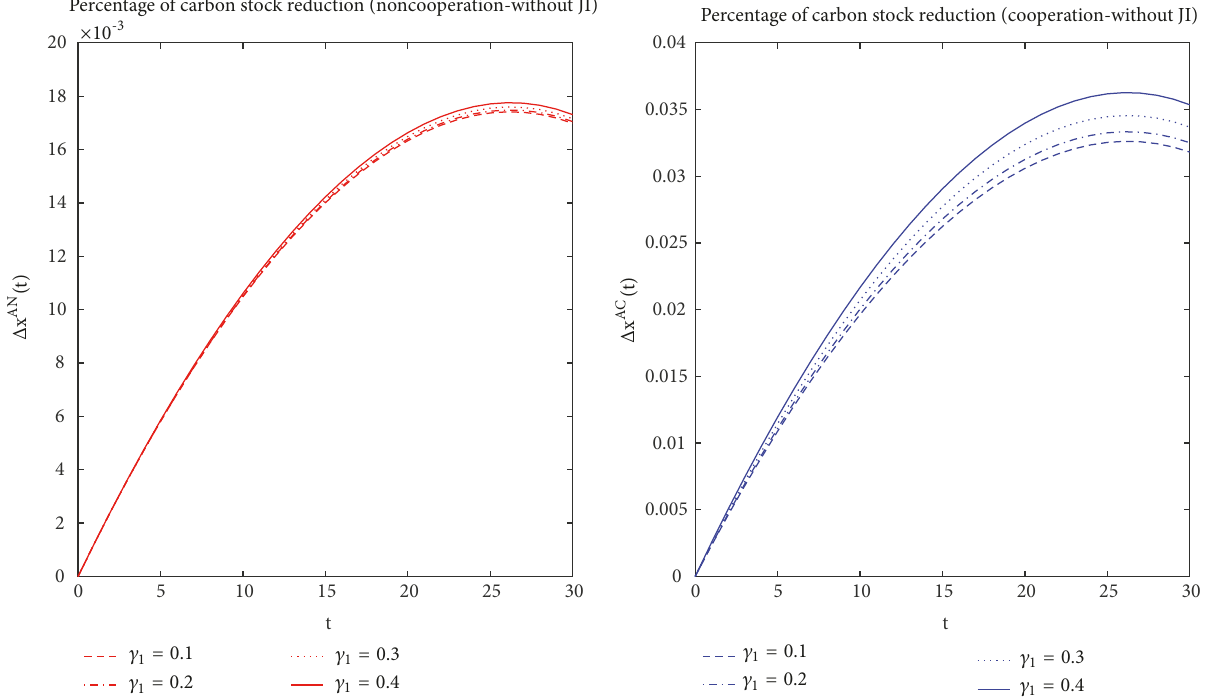
Figure 6: The behavior of percentage of carbon stock reduction as 𝛾 1 changes.